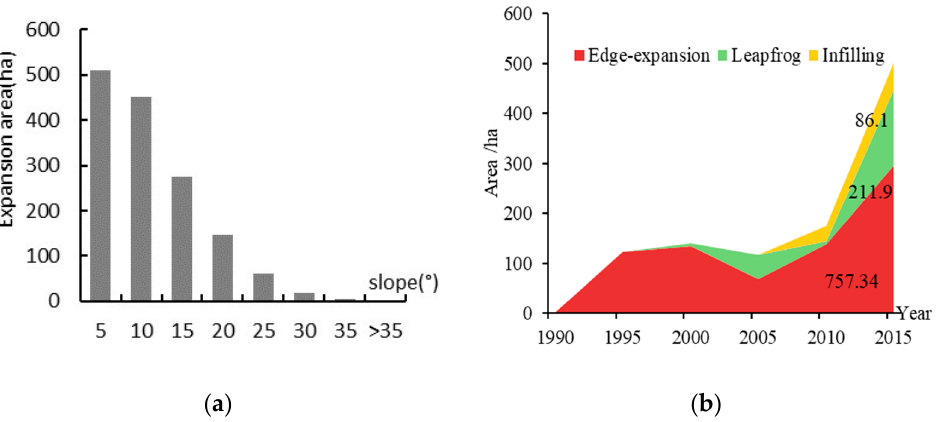
Figure 3. Rural residential land growth in Baota during 1990–2015. Subfigure ( a ) showed the relation between rural residential land expansion and slope in Baota; subfigure ( b ) showed an area-stacked chart of rural residential land expansion patterns in Baota.